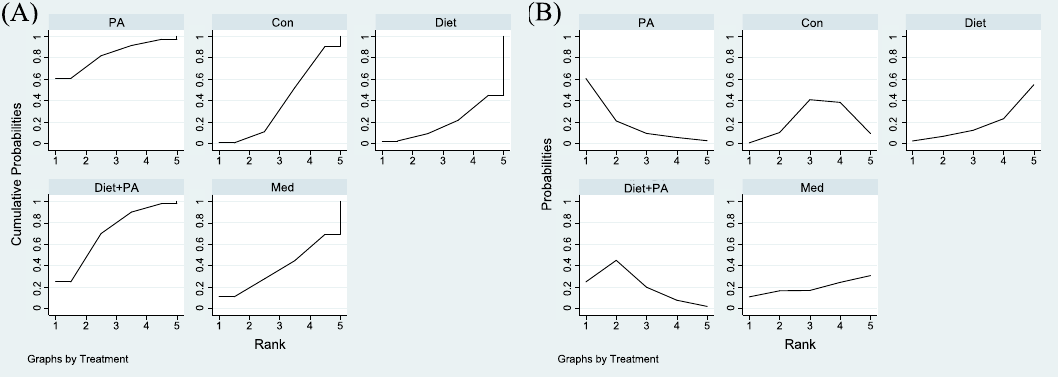
Figure 4. Surface Under the Cumulative Ranking for the incidence of GDM ( A ). Rankograms for the incidence of GDM ( B ) were derived from relevant surface under the cumulative ranking (SUCRA) values for various regimens. Abbreviations: physical activity, PA; control, Con; medication, Med .